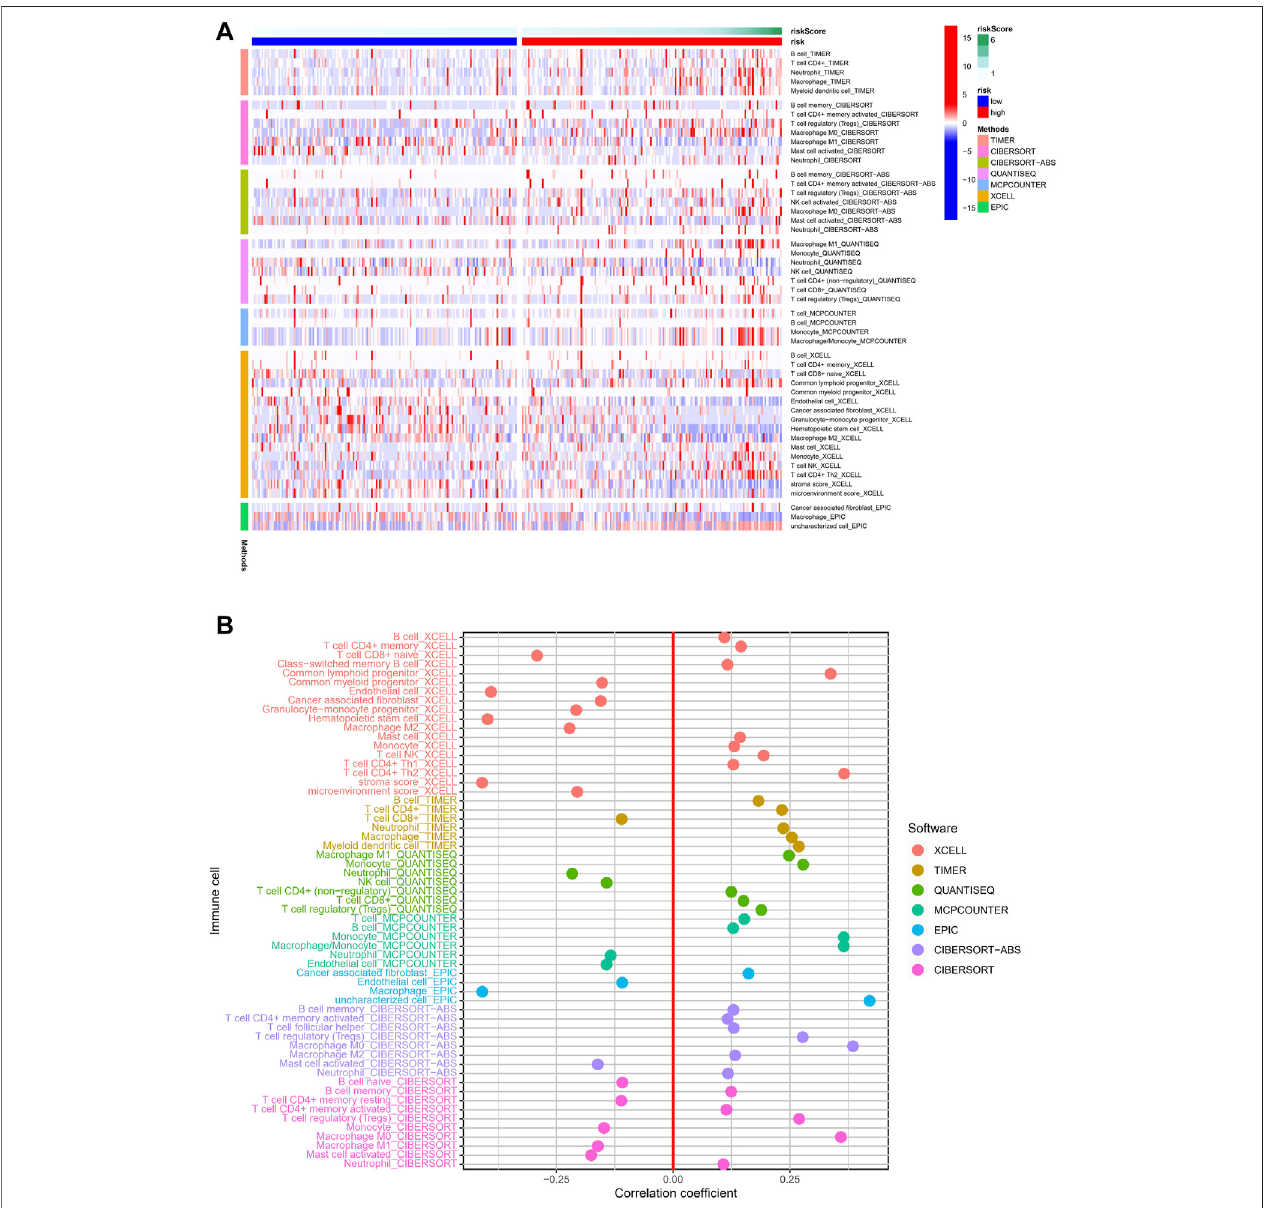
FIGURE 8 | Relationship between immune cells and risk score. (A) TIMER, CIBERSORT, CIBERSORT-abs, QUANTISEQ, MCP-counter, XCELL, and EPIC algorithms were used to draw heat maps of immune cell in fi ltration of patients with different risk scores. (B) Correlation coef fi cient between immune cells and risk score.